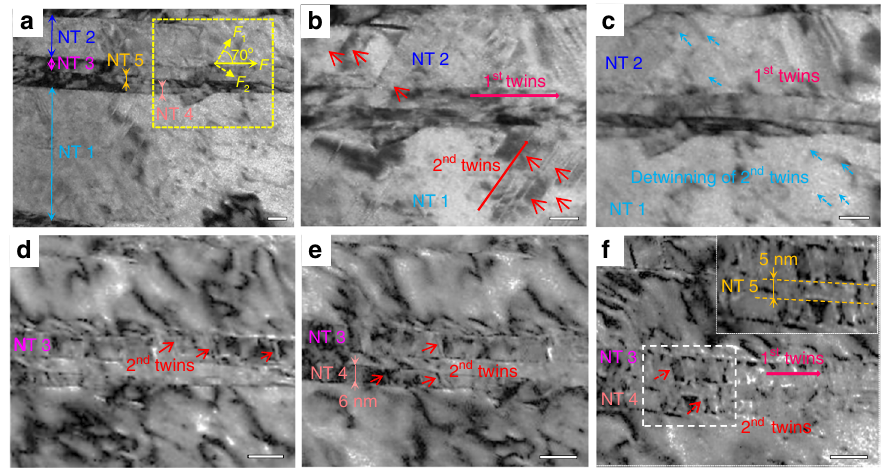
Fig. 3 Secondary twinning of the NTs. a Morphologies of the fi rst NTs 1 – 5, with λ of 129, 42, 15, 6, 5 nm, respectively. b – f Magni fi cations of the yellow rectangular zone in a . Under tensile loading, bundles of the second NTs are initiated in the fi rst NTs 1 and 2 and exhibit detwinning, as shown in b and c , respectively. After the detwinning of the second NTs in NTs 1 and 2, a new round of secondary twinning and detwinning occurs in NTs 3 and 4, as shown in d – f . The inset in f is a magni fi cation of the white rectangular zone in f , where no secondary twinning was observed in NT 5. F is the external tensile stress, and F 1 and F 2 are the shear components. The fi rst twins and second twins represent the primary and secondary twins, respectively. The standard deviations of the determined λ are 20 nm for NT 1 and 1 nm for NTs 2 – 5. The time frames of a – f are 0, 5, 7, 10, 15 and 20 s, respectively. All scale bars are 20